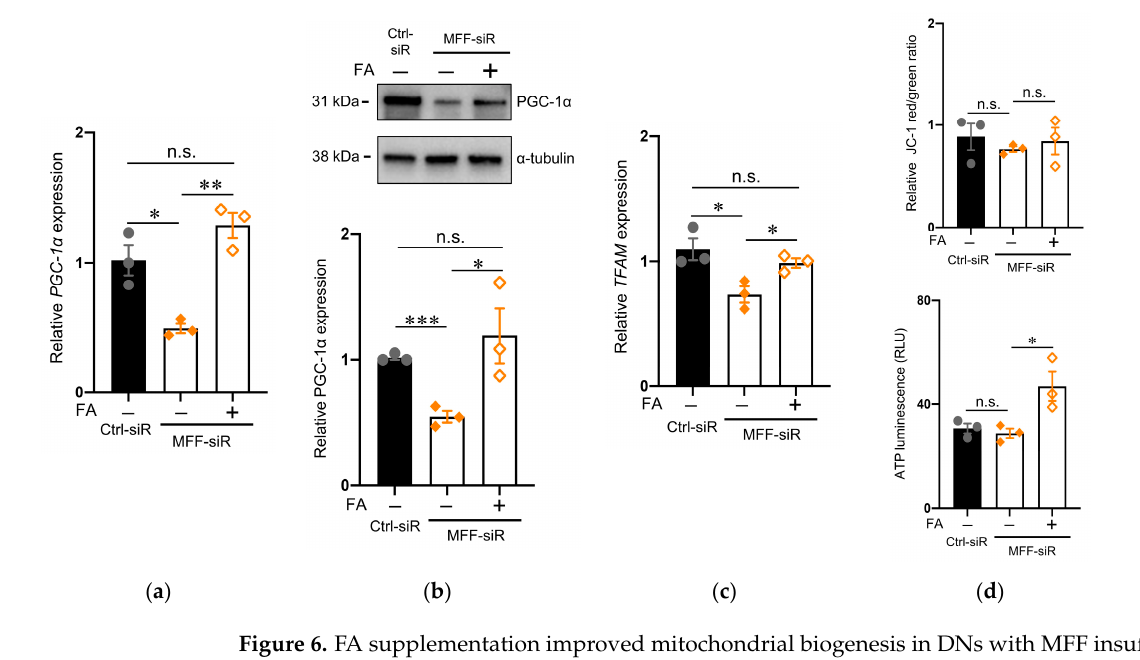
Figure 6. FA supplementation improved mitochondrial biogenesis in DNs with MFF insufficiency.